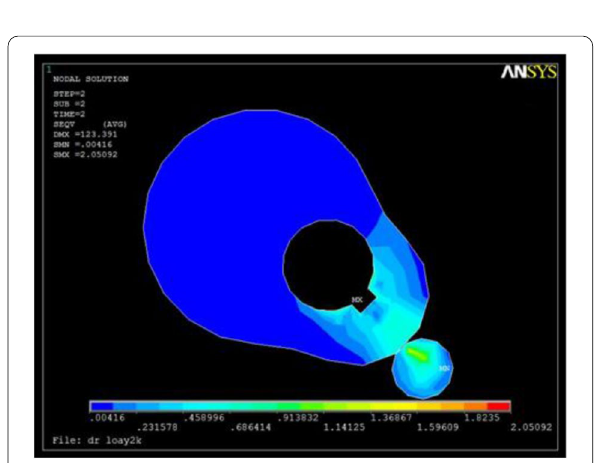
Figure 19 bending deflection against the contact angle of path No. (1)